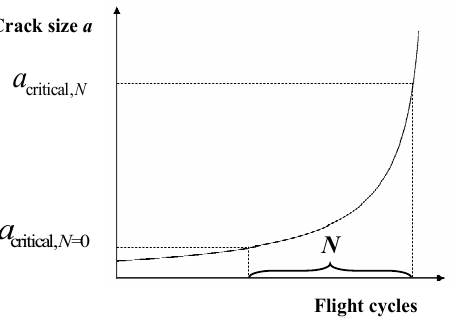
Figure 4. Initial defect distribution curve.